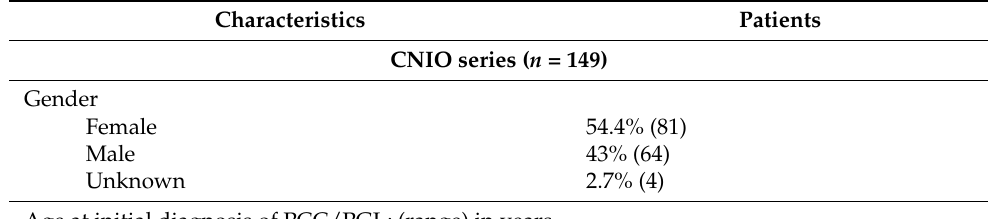
Table 1. Summary of PPGL series clinical